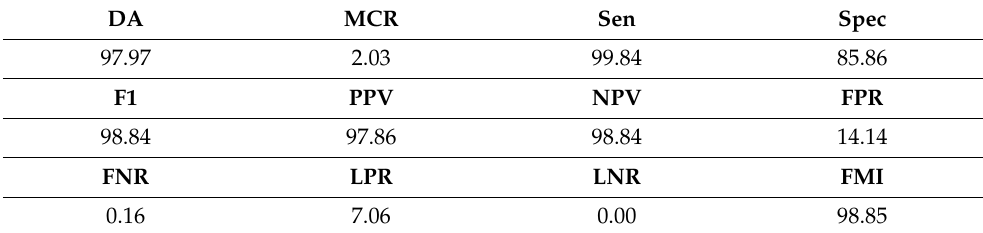
Table 10. Performance Analysis of KNN (%) During Testing